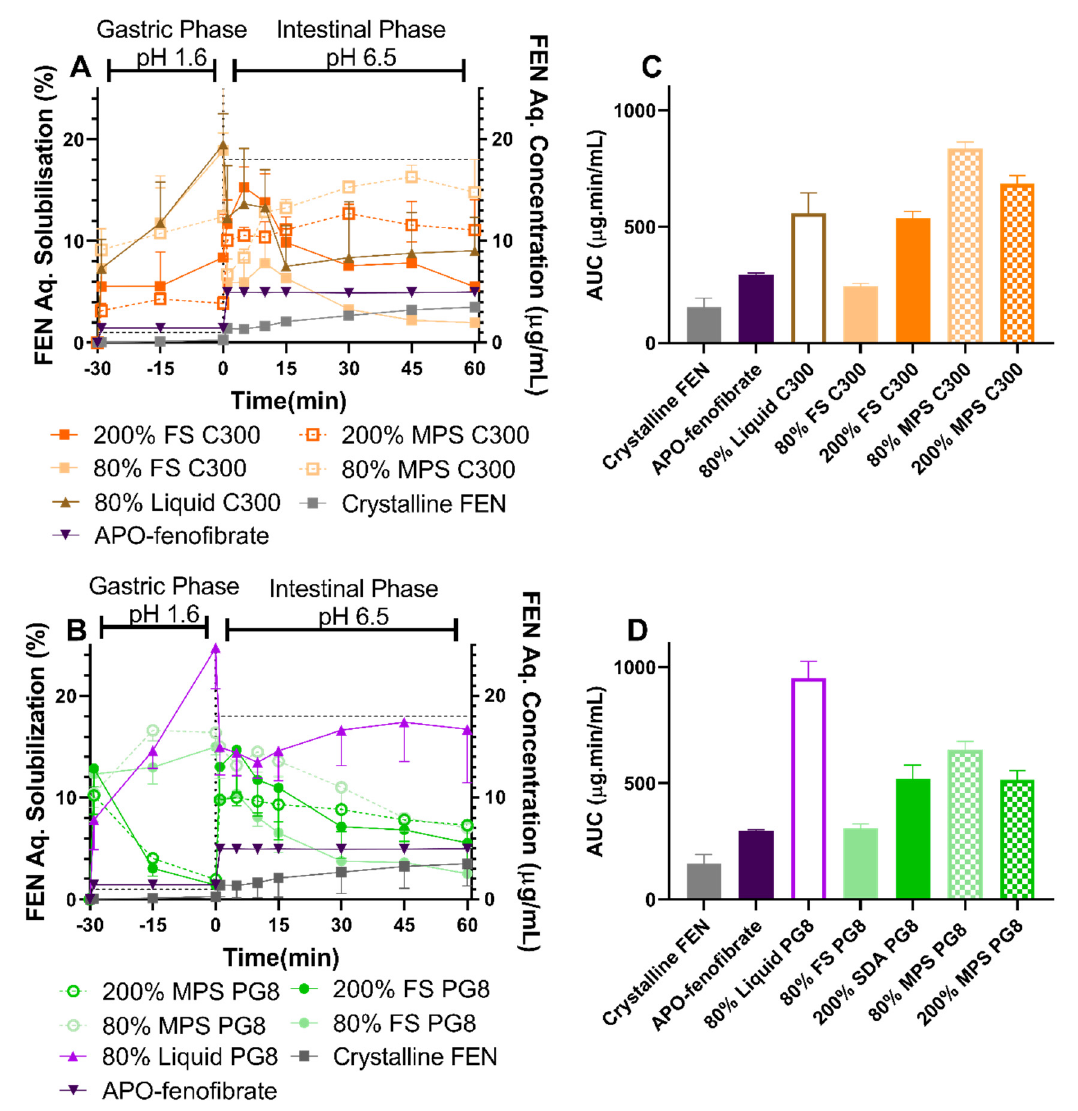
Figure 6. FEN aqueous concentration-time profiles from crystalline FEN, APO-fenofibrate, and FEN-loaded SLH formulations, in fasted state simulated gastric fluid (FaSSGF) (30 min) and fed state simulated intestinal fluid (FaSSIF) (60 min) under digesting conditions, dosed at 3 mg of FEN (mean ± SD, n = 3). ( A ) SLH C300 formulations and ( B ) SLH PG8 formulations. Dotted line represents the FEN S eq in biorelevant media. The area under the curve (AUC) of FEN aqueous solubilization-time profile measured during the intestinal phase from ( C ) crystalline FEN, APO-fenofibrate, and SLH C300 formulations and ( D ) crystalline FEN, APO-fenofibrate, and SLH PG8 formulations.